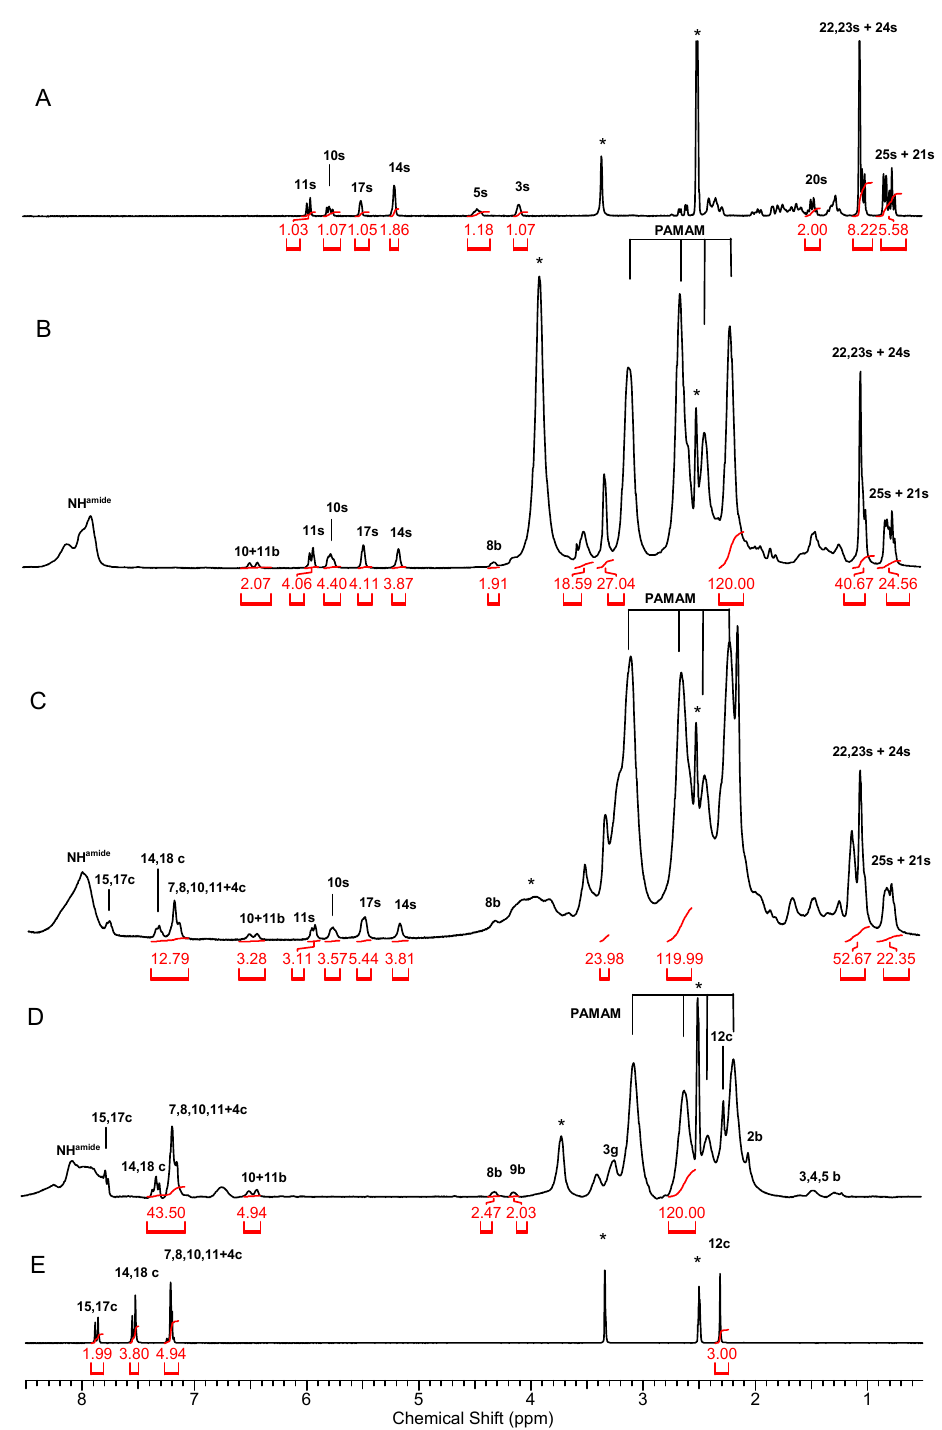
Figure 1. The 1 H NMR spectra of simvastatin ( A ), G3 2B4S14gl ( B ), G3 2B2C4S12gl ( C ), G3 2B6C8gl ( D ), and celecoxib ( E ) in DMSO-d 6 . Residual HD 2 CS(O)CD 3 and HDO peaks are labeled with asterisks *. The PAMAM CH 2 resonances centered at 2.63 ppm or 2.20 were used as internal integration reference (the integral intensity of both resonances corresponds to [120H]).